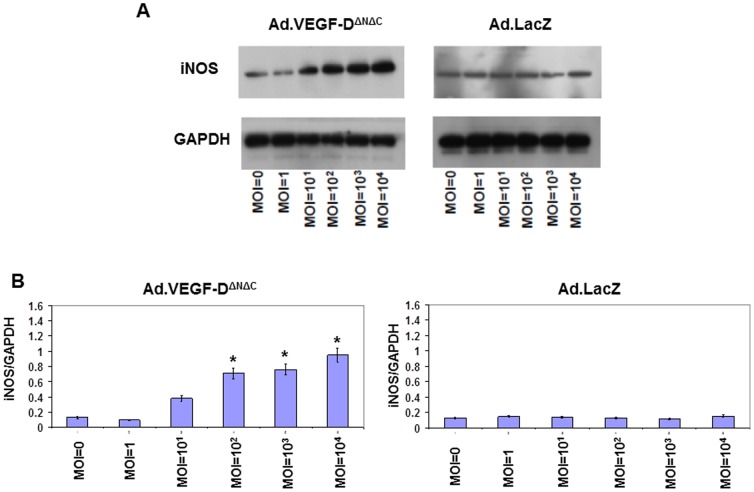
Representative western blots showing an upregulation in iNOS levels 48-DΔNΔC infection in pregnant sheep UAECs.Pregnant sheep UAECs were grown in culture for upto 4 passages, and then infected at increasing MOIs with Ad.VEGF-DΔNΔC or Ad.LacZ in 6-well plates. Protein was extracted from infected cells 48 hours later, and assayed for iNOS levels by western blotting. (A) A dramatic increase in iNOS levels with increasing MOI was observed in Ad.VEGF-DΔNΔC infected cells, but not Ad.LacZ infected cells. (B) Densitometric analysis was performed on the iNOS bands using Image J software, after normalizing against the density of GAPDH bands. Results are representative of n = 3 independent experiments. * indicates p<0.05 in comparison to the relative density of the corresponding band from uninfected cells (MOI = 0) by t-test.